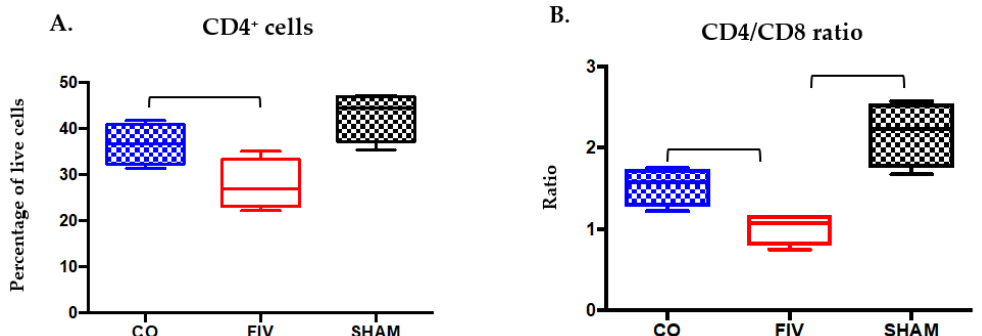
Figure 7. Prescapular lymph node CD4 + live cell percentages (( A ) P = 0.0475) and CD4/CD8 ratios (( B ) P = 0.02) were higher in CO when compared to FIV cats at 4 weeks FIV PI. CD4 + live cell percentages and CD4/CD8 ratios were also higher in the SHAM compared to FIV cats (CD4 + : P = 0.008; CD4/CD8 ratio: P = 0.0011), but not between the SHAM and the CO cats.